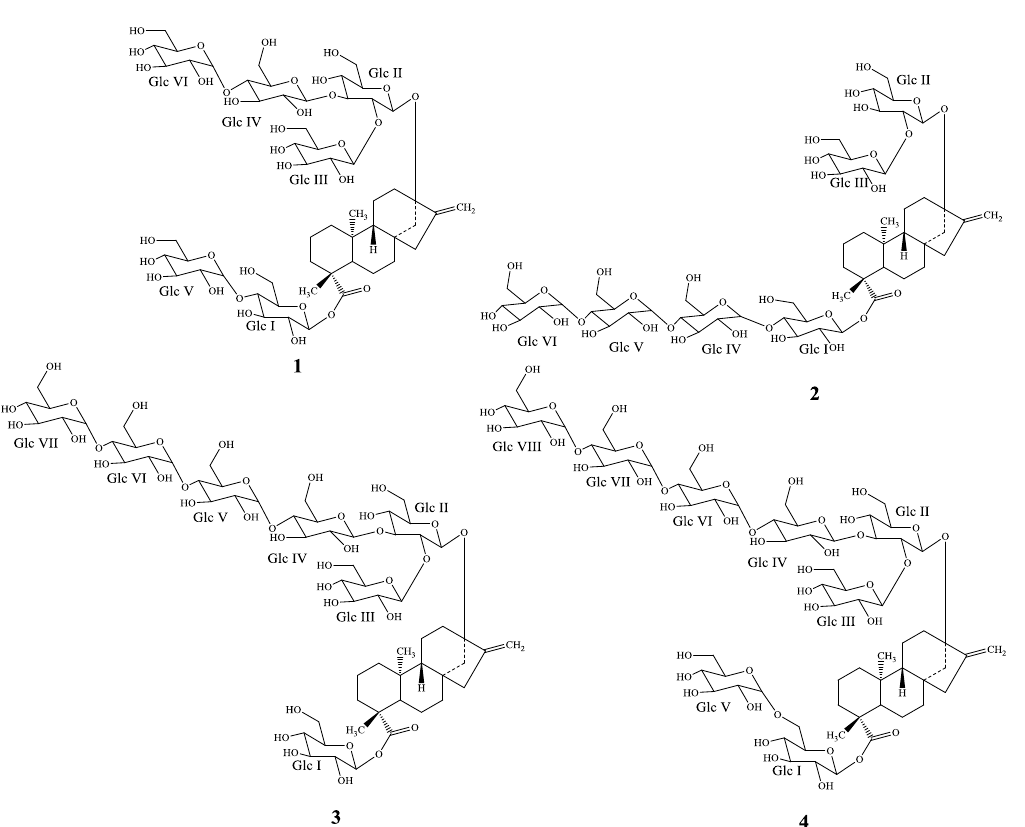
Figure 1. Structures of the new steviol glycosides 1 – 4